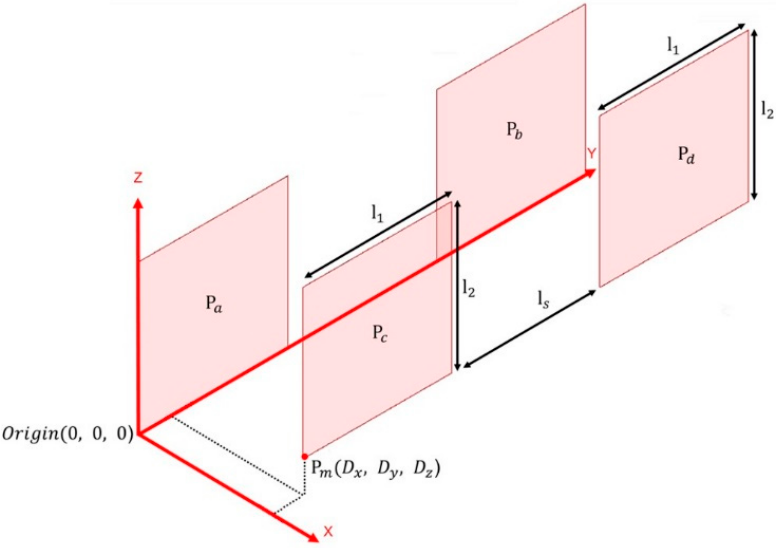
Figure 2. Parameters of the proposed capacitive coupler.